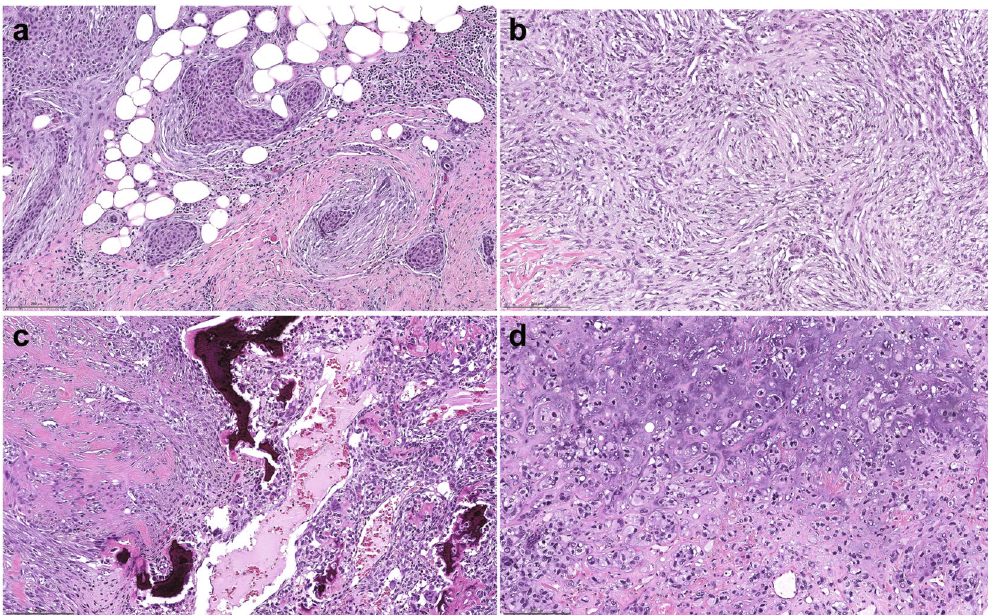
Fig. 1 Histologic features of the metaplastic breast cancers included in this study. Representative hematoxylin-and-eosin photomicrographs of metaplastic breast cancers (MBCs) with predominant a squamous cell carcinoma component (MBC103T), b spindle cell component (MBC118T), c osseous metaplasia component (MBC120T), and d chondroid metaplasia component (MBC108T). Scale bars, 200 μ M.